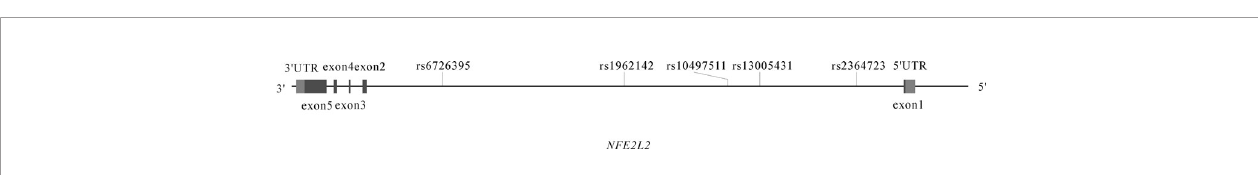
FIGURE 1 | NFE2L2 gene structure and location of fi ve tagSNPs (rs10497511, rs2364723, rs13005431, rs6726395 and